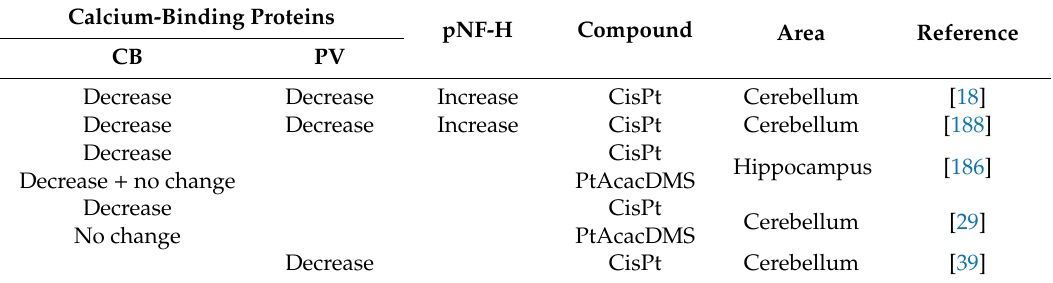
Table 2. E ff ect of platinum compounds treatment on CBPs localization and NF-H phosphorylation in the rat CNS. CisPt: cisplatin (CisPt), PtAcacDMS: [Pt( O,O (cid:48)